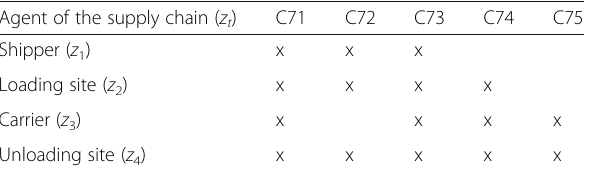
Table 5 Quantifiable barriers affecting agents of the supply chain